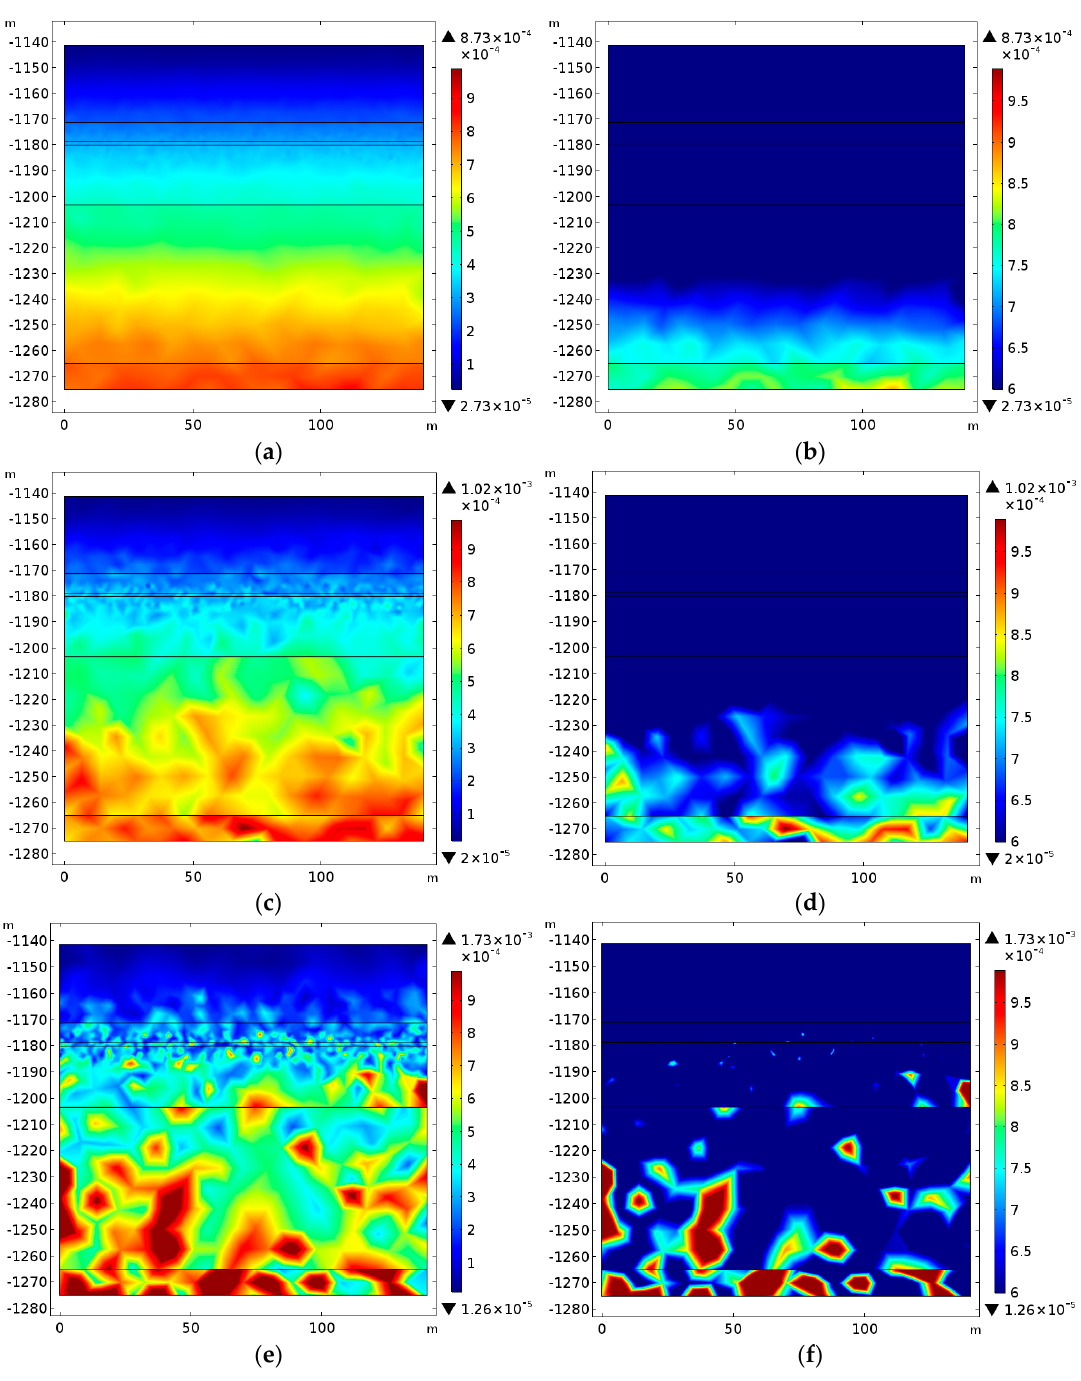
Figure 14. The fluid velocity distribution of homogeneity rock and different heterogeneity rock (pH = 6.6): ( a ) k w = 50; ( b ) k w = 50, the fluid velocity over average value 6 × 10 − 4 m / s; ( c ) k w = 8; ( d ) k w = 8, the fluid velocity over average value 6 × 10 − 4 m / s; ( e ) k w = 2; ( f ) k w = 2, the fluid velocity over average value 6 × 10 − 4 m / s.